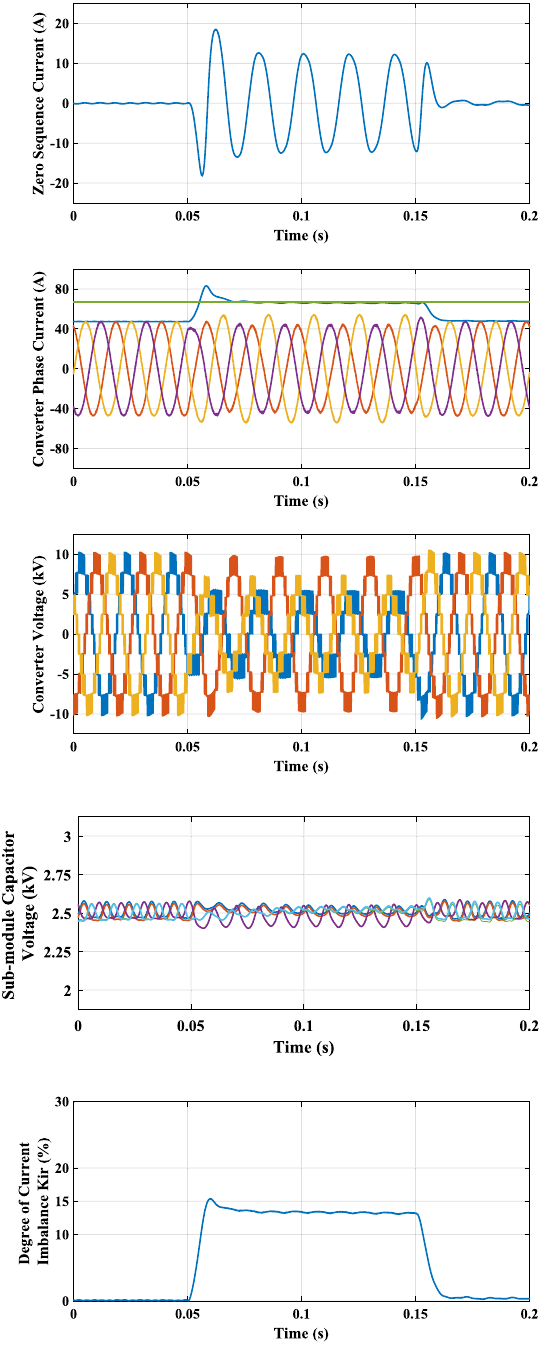
Fig. 10 Simulation result using proposed technique. a Zero sequence current. b Converter phase currents. c Converter voltages. e Degree of current